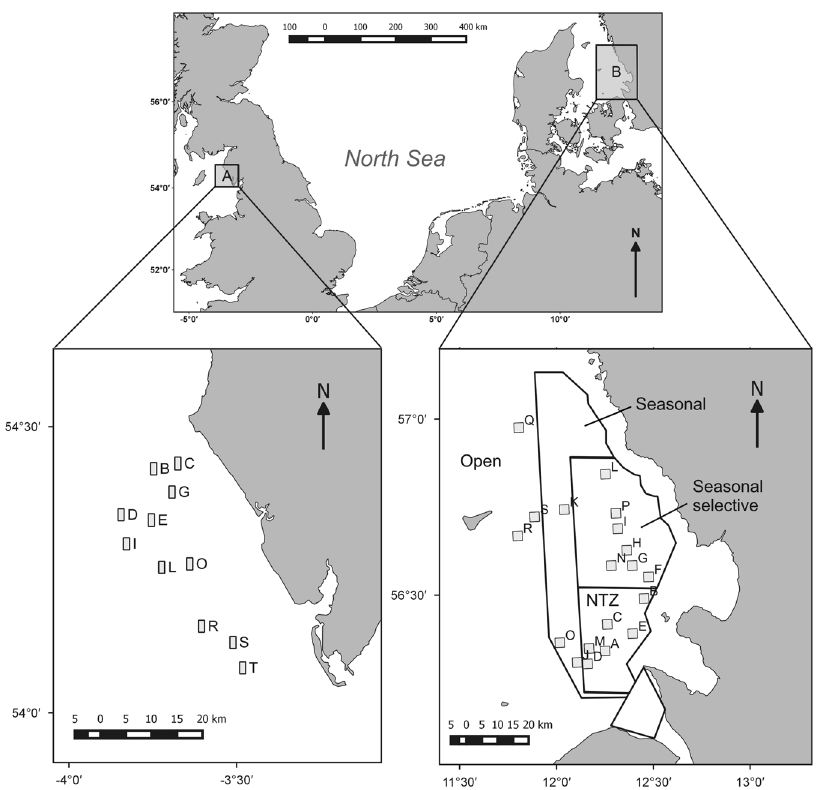
Maps were created with the software package QGIS Lyon